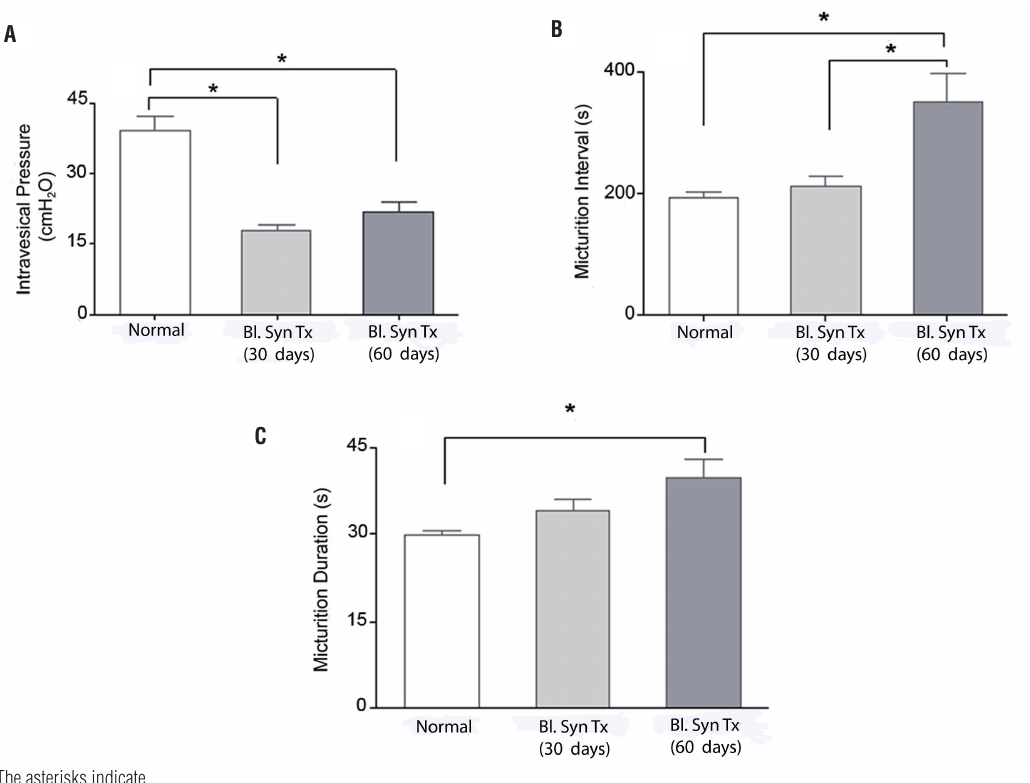
Figure 4 – Cystomanometric recordings of female ShR rats which underwent bladder transplantation performed 30 and 60 days after surgery. The rats were anesthetized with urethane for evaluation of the maximal pressure amplitude of the bladder (A), micturition interval (B) and micturition duration (C). Flow rate of the bladder perfusion (0.9% saline solution) was 0.08 ml/min (at 37ºC).